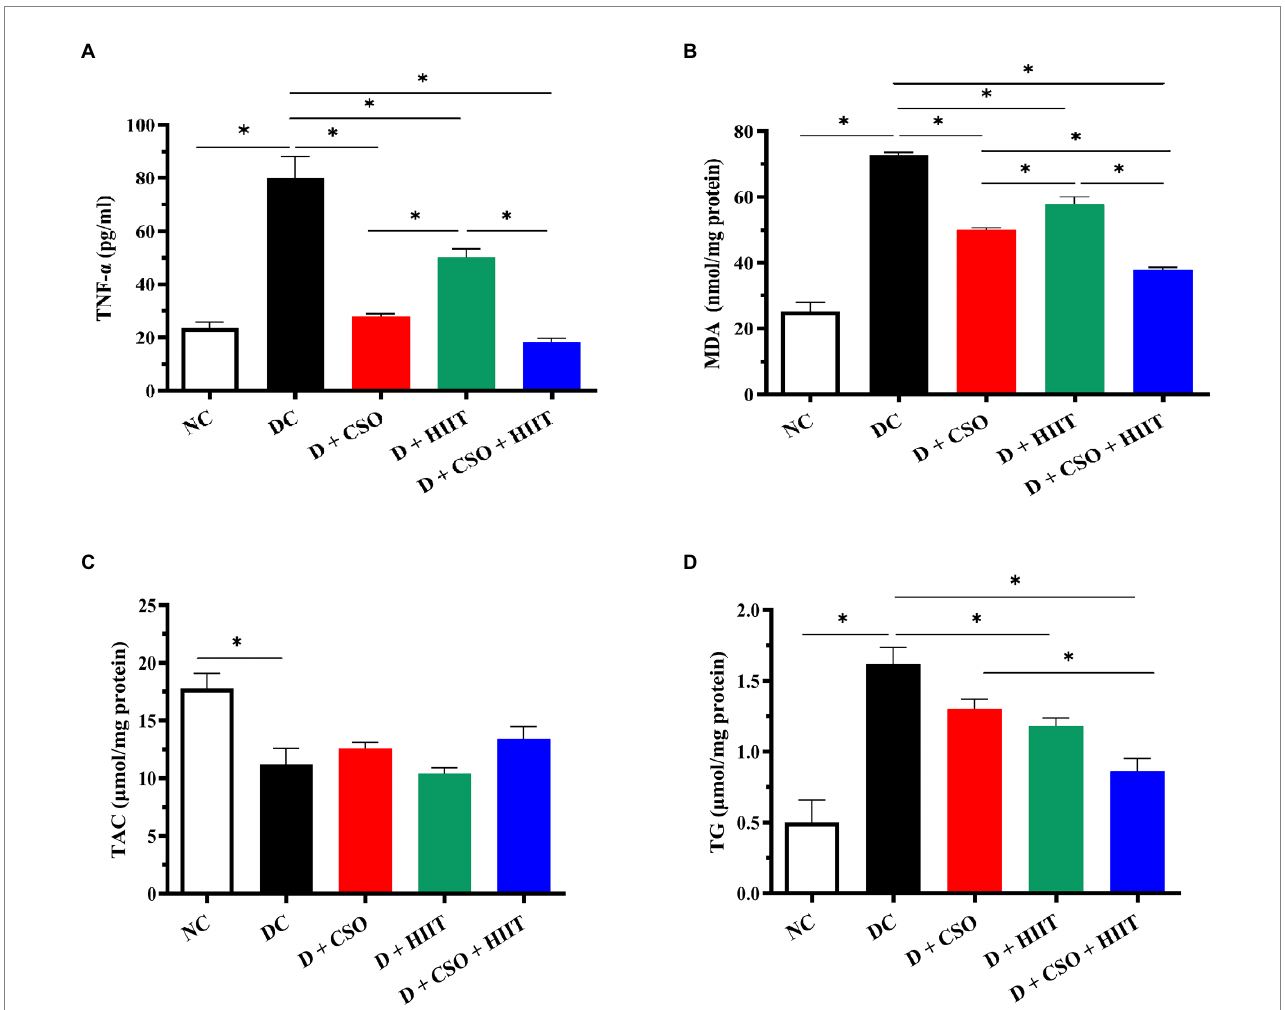
FIGURE 2 The effect of D, D + CSO, D + HIIT, and D + CSO + HIIT on hepatic (A) TNF- α , (B) MDA, (C) TAC, and (D) TG. One-way ANOVA followed by Tukey post-test was used. Data are represented as means ± SEM and significant differences between groups are indicated by * p < 0.05. NC, Normal control; DC, Diabetic control; D + CSO, Diabetic + camelina sativa oil; D + HIIT, Diabetic + HIIT; D + CSO + HIIT, Diabetic + camelina sativa oil +